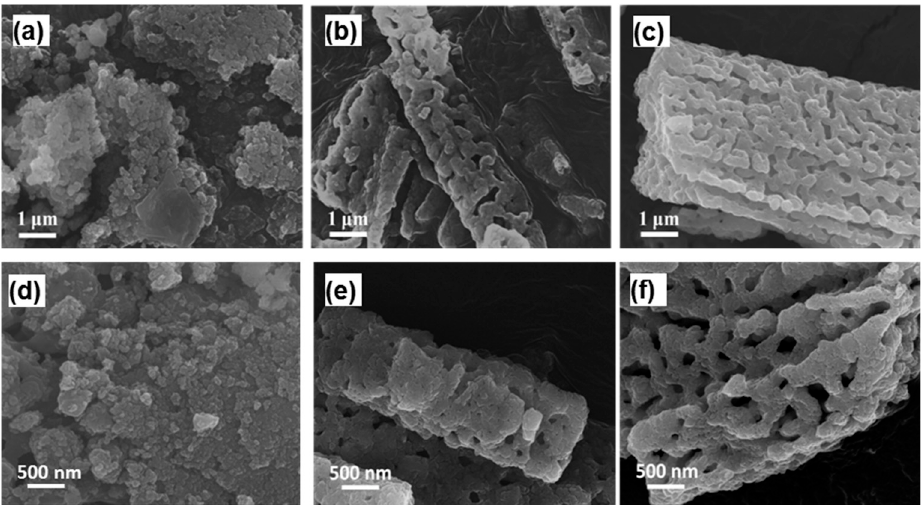
Figure 6. SEM images of as-calcined samples for ( a ) Ca-MOF-24h-10-O, ( b ) Ca-MOF-24h-5-O and ( c ) Ca-MOF-24h-1-O. After the 10 th carbonation–calcination cycle, the SEM morphology images of ( d ) Ca-MOF-24h-10-O, ( e ) Ca-MOF-24h-5-O and ( f ) Ca-MOF-24h-1-O.